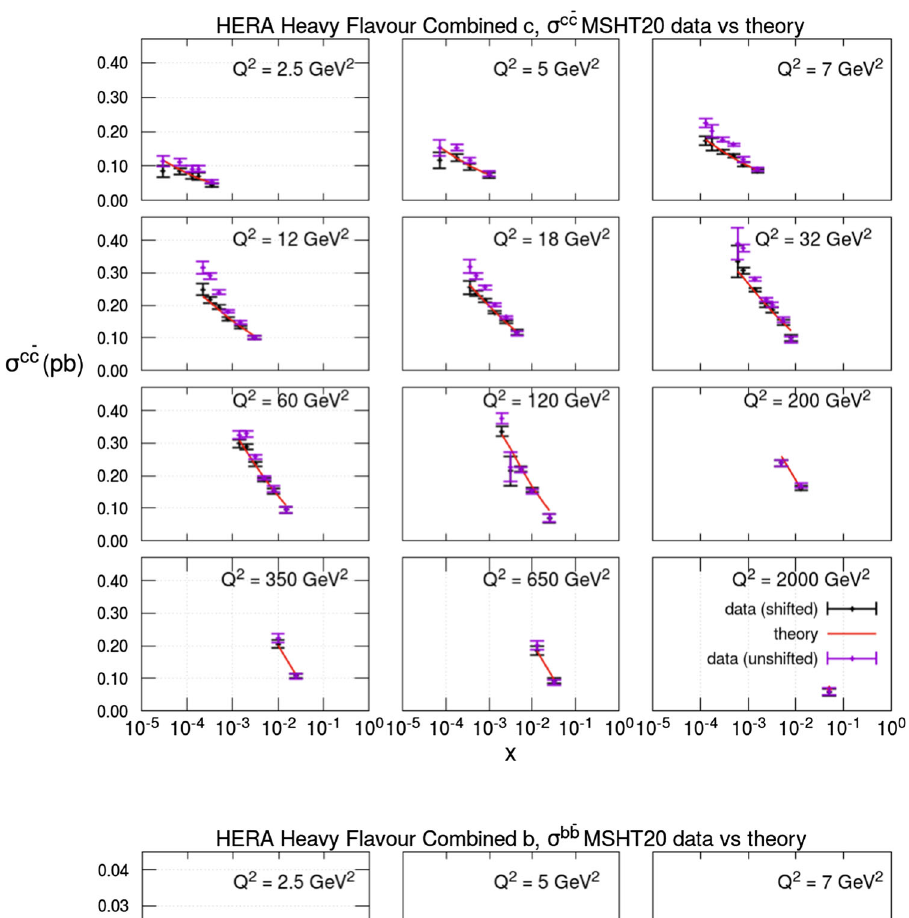
Fig. 4 Fit quality for the combined HERA heavy flavour data for the charm quark. Purple represents the unshifted data, black are the shifted data and the red line is the MSHT20 theory prediction with these data included in the fit. The errors plotted are the total uncorrelated errors for each point